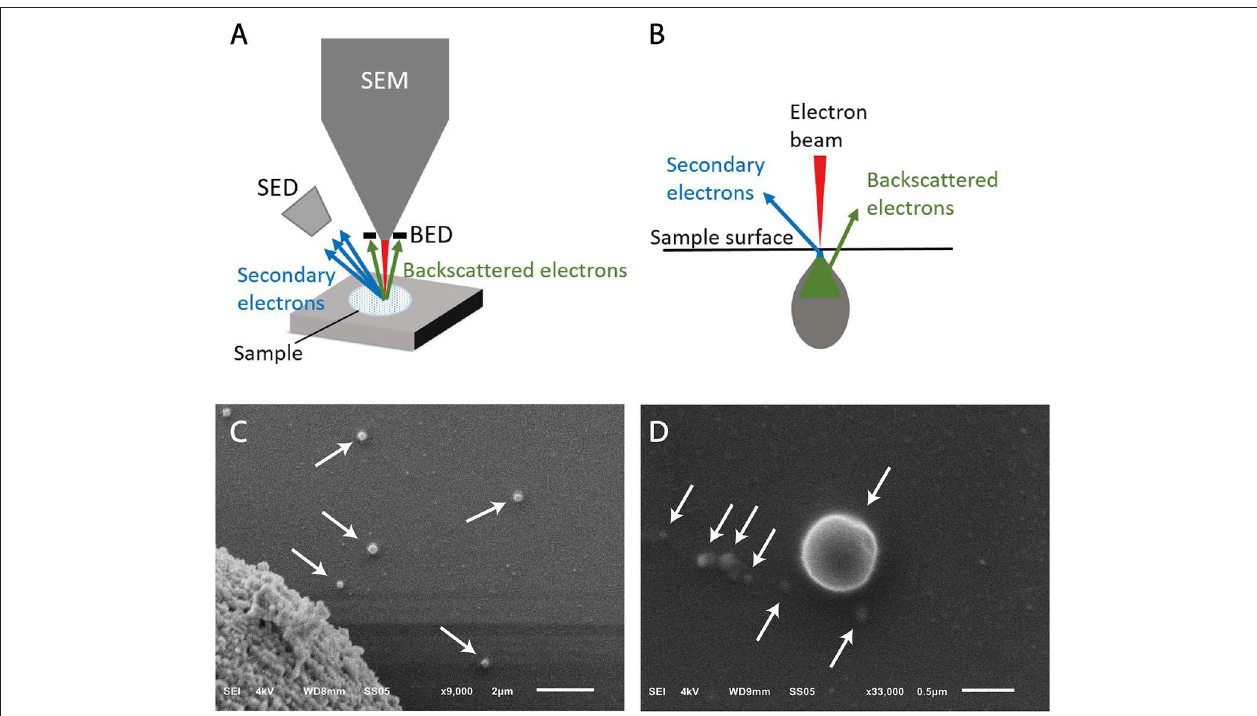
FIGURE 4 | Scanning electron microscopy (SEM) of extracellular vesicle (EV) samples. (A) Schematic representation of a SEM setup. SED, secondary electron detector; BED, backscatter electron detector. (B) The sample is illuminated by the electron beam. Electrons interact with the sample at different depths, resulting in emitted electrons from the surface (secondary electrons) and from deeper layers (backscattered electrons). (C) SEM image of LNCaP EVs indicated by arrows. The large object in the left lower corner is part of a LNCaP cell floating in the cell supernatant and was imaged to show that the contrast of EVs is similar to cells. The scale bar represents 2 µ m. (D) Higher magnification allows imaging of smaller particles, possibly EVs, with lower contrast. The scale bar represents